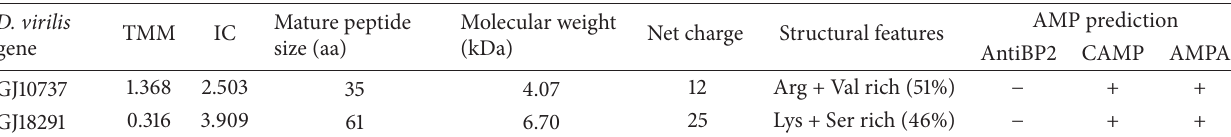
Table 4: Trimmed mean of M value (TMM), induction coefficient (IC), number of amino acids of mature peptide, molecular weight, net charge and protein structural feature for putative antimicrobial peptide genes in D. virilis predicted by AMP prediction programs. D.